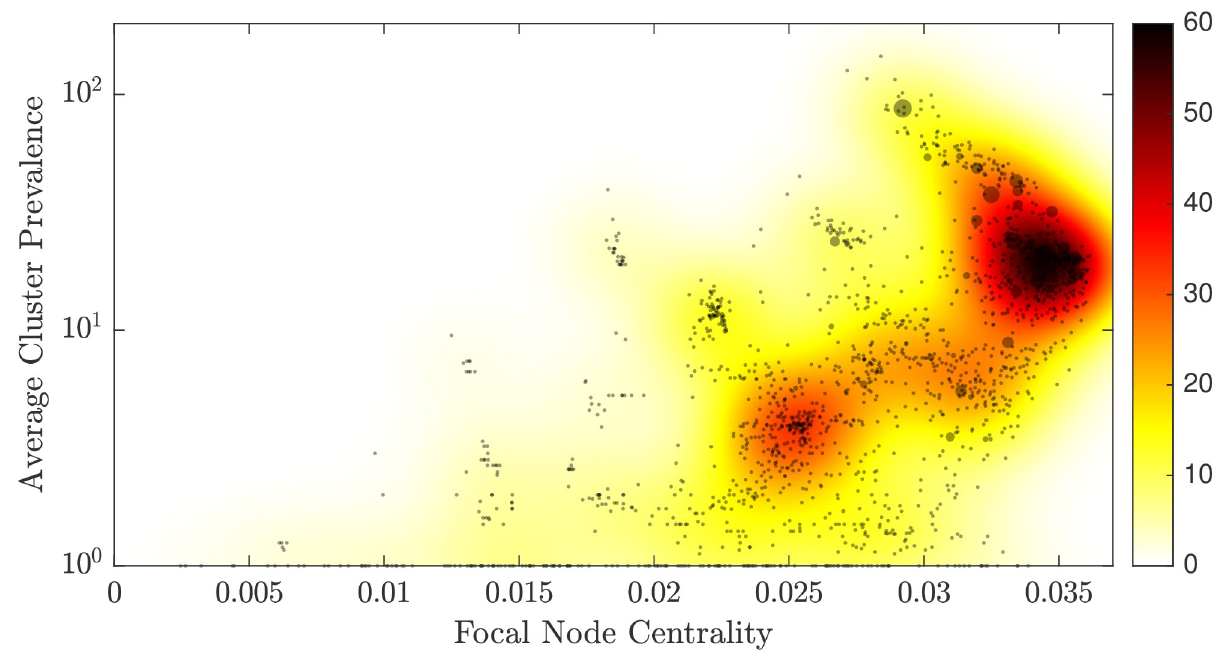
Fig 4. The structure of the centrality-prevalence space, revealed by the expected value of the positive gain in prevalence. For every MLVA profile, the point size is shown in proportion to the average change in prevalence. The size is set to one if the change is negative, so that the contribution of all unsuccessful paths with negative change in prevalence is bounded. Colour intensity indicates the estimated density, given the average changes in prevalence for all profiles. The transition region (intense red colour) is shaped by the profiles with high centrality and medium cluster prevalence, i.e., node centrality between 0.0329 and 0.0359, and cluster prevalence between 10 1.14 and 10 1.46 . The evolutionary paths originating from profiles in this region tend to produce the higher average change in prevalence, that is, these paths develop from right to left and from bottom to top.